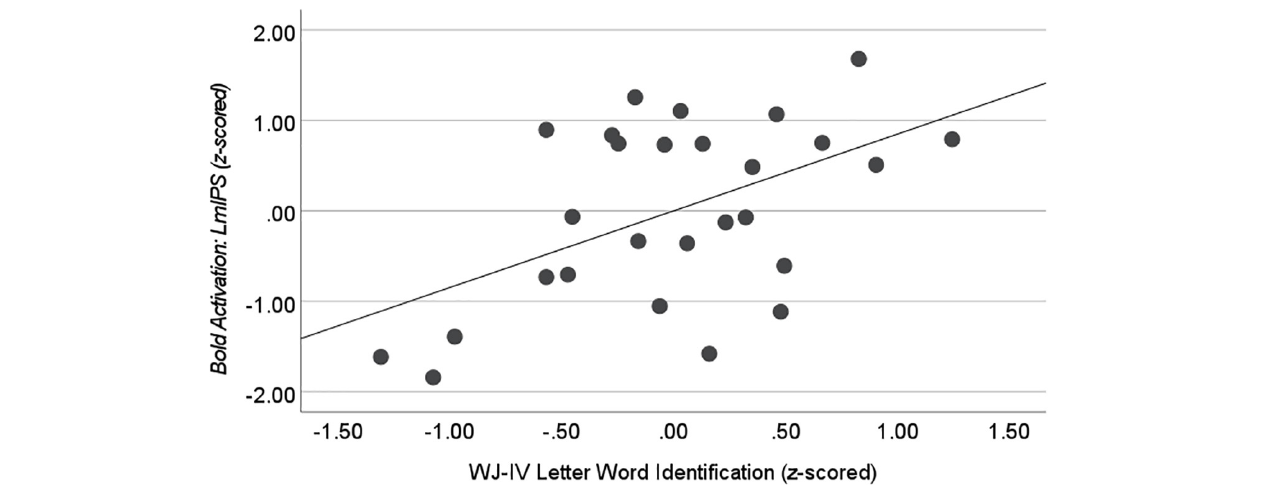
FIGURE 9 | Correlation with WJ-IV Letter Word Identification during Write Ink. Activation in the left middle intraparietal sulcus (LmIPS) correlated with performance on the WJ-IV Letter Word Identification in the child participants after controlling for age ( r = 0.515, n = 27, p =